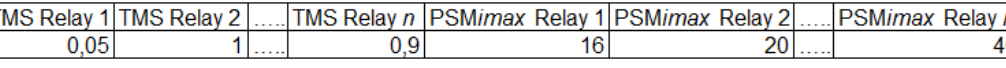
Figure 3. Example of a candidate solution or